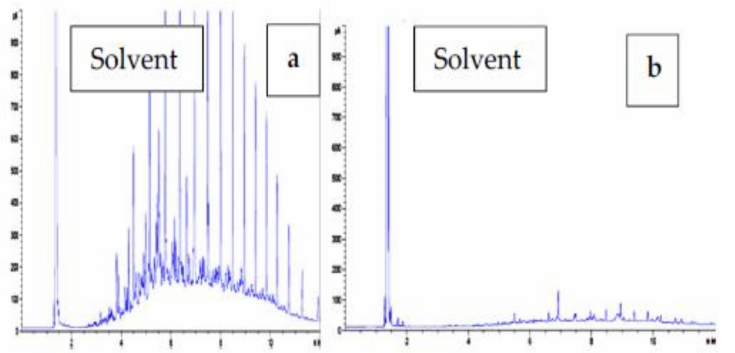
Figure 9. Comparative chromatograph of ( a ) contaminated non-rhizosphere (CN) and ( b ) contami- nated rhizosphere (3% oily sludge with C. cajan ) after 90 days.